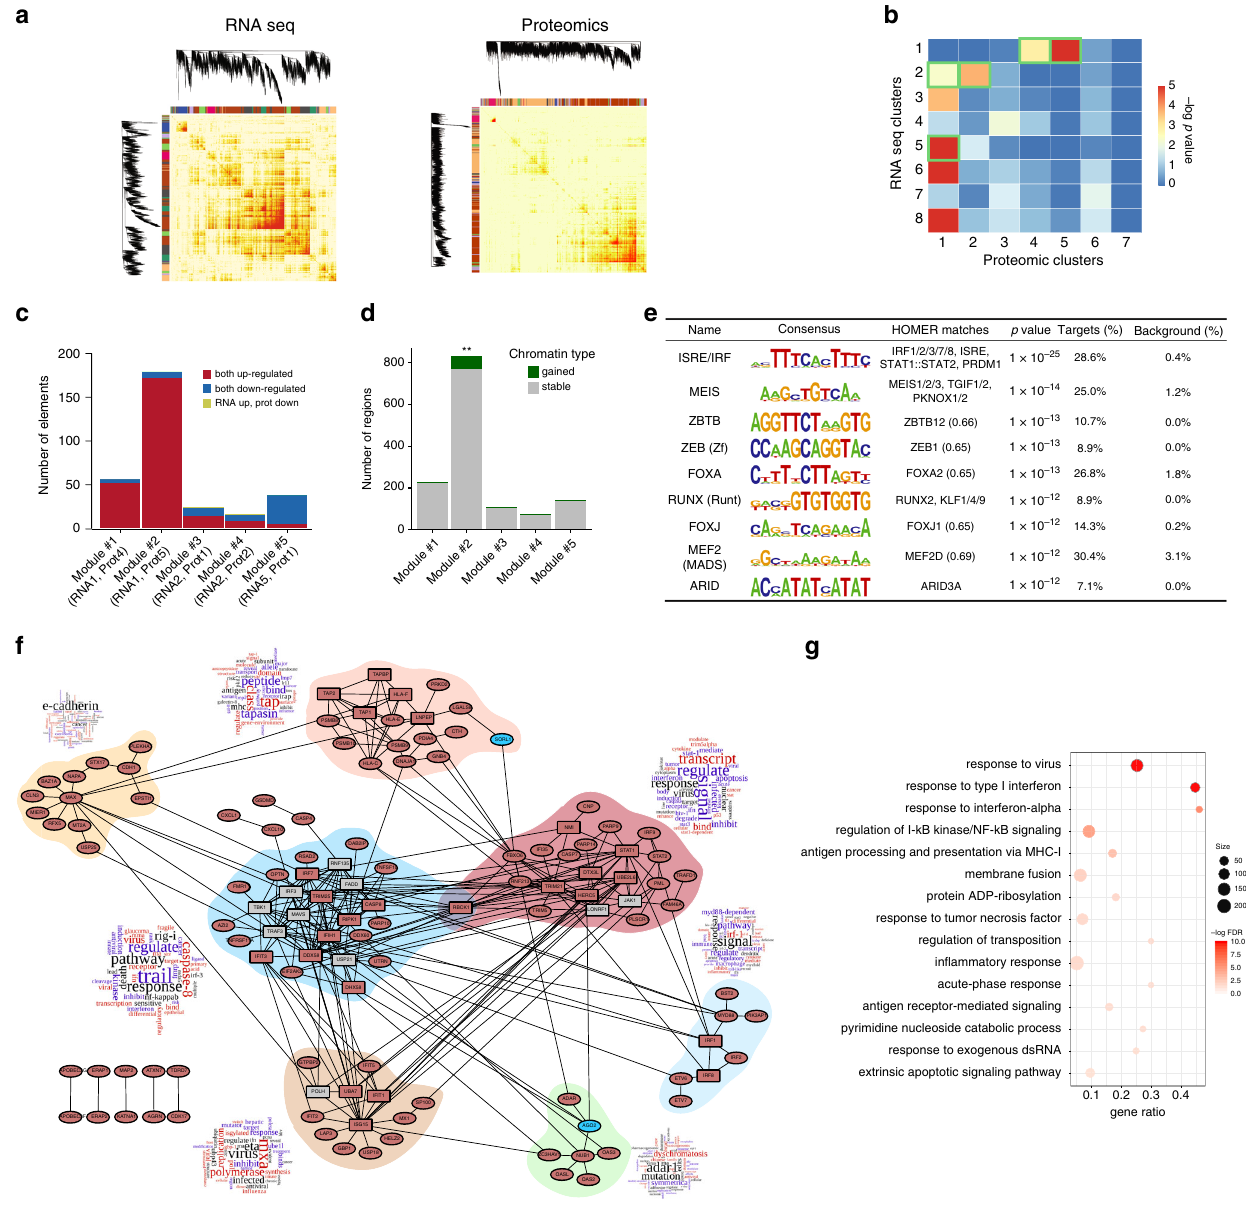
Fig. 4 Weighted correlation network analysis (WGCNA) identi fi es IFN α -regulated mRNA and protein modules. a Heatmap representation of the topological overlap matrix. Rows and columns correspond to single genes/proteins, light colors represent low topological overlap, and progressively darker colors represent higher topological overlap. The corresponding gene dendrograms and initial module assignment are also displayed. b Identi fi cation of modules presenting signi fi cant overlap (FDR < 0.05 and a minimum of 10 members in common) (green border) between differentially expressed genes (DEG) and their translated differentially abundant proteins (DAP). c Composition, number of elements and type of DEG and DAP present in each of the signi fi cantly overlapping modules. d ATAC-seq-identi fi ed open chromatin regions at 2 h were linked to gene transcription start sites (TSSs) in a 40 kb window. These genes and their open chromatin regions were associated to the modules of DEG and DAP. The enrichment for gained open chromatin regions was then evaluated in each module. (** represents a p -value = 0.002343, one-sided χ 2 test). e De novo HOMER motifs present in the ATAC-seq regions overlapping module #2 as described in Methods. The unadjusted p -values were obtained using the hypergeometric test from the HOMER package 77 . f The protein – protein interaction (PPI) network of module #2 was done using the InWeb InBio Map database 31 . Enriched proteins (FDR < 0.05 and minimum number of connections = 5, represented as squares) were identi fi ed and added to the network if they were not already present. Red fi ll identi fi es upregulated proteins, blue fi lls downregulated proteins and gray fi ll equal-regulated. Colored regions delimitate communities of proteins, as described in Methods. The wordcloud next to each community presents their enriched geneRIFs terms. g The biological processes (GO) overrepresented in module #2 summarize the main fi ndings observed in IFN α -treated human beta cells. The present results were based on RNA-seq ( n = 5) and proteomics ( n = 4) data of EndoC- β H1